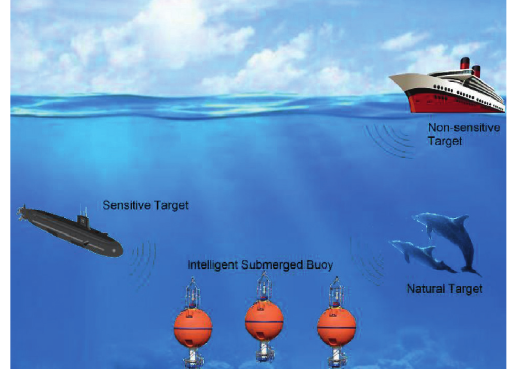
Figure 1: System model of the underwater acoustic detection system for moving target.